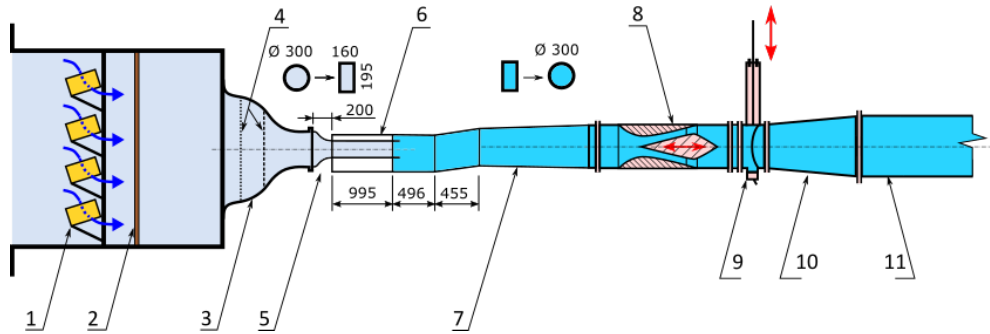
Figure 8. Scheme of the wind tunnel. 1 silica-gel dryer, 2 pebble and cloth filter, 3 circular contraction, 4 honeycomb and screen, 5 contraction and cross-section change insert, 6 test section, 7 diffuser and cross section change insert, control nozzle, 9 quick acting valve, 10 diffuser, 11 pipe connection to vacuum chamber; dimensions given in mm.